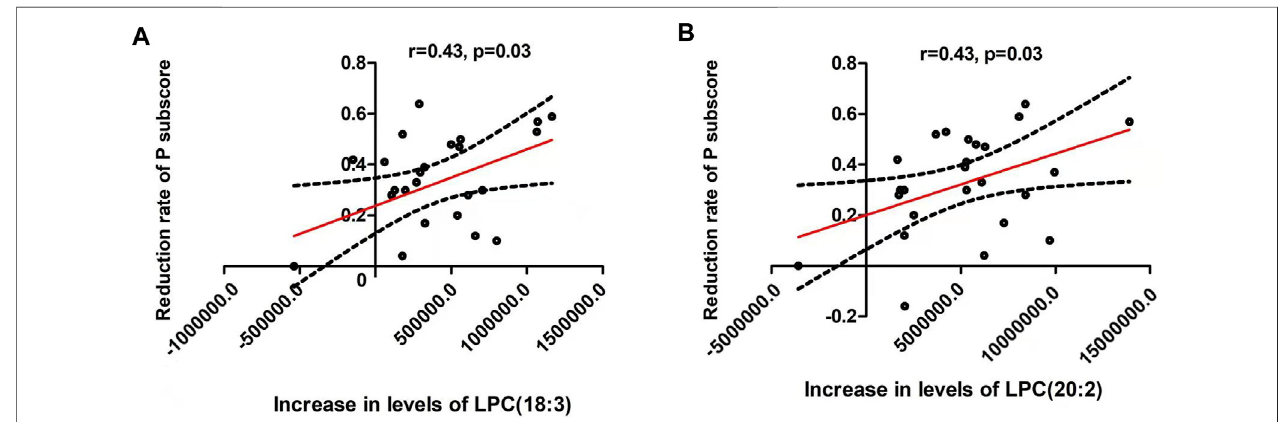
FIGURE 2 | There were significant positive associations between the reduction of positive symptoms and the increase of lysophosphatidylcholine (LPC) (18:3) (A) and LPC(20:2) (B) (both were: r (cid:2) 0.43, p (cid:2) 0.03). The red line represents the trend line, and the dashed black line is the 95% con fi dence interval.